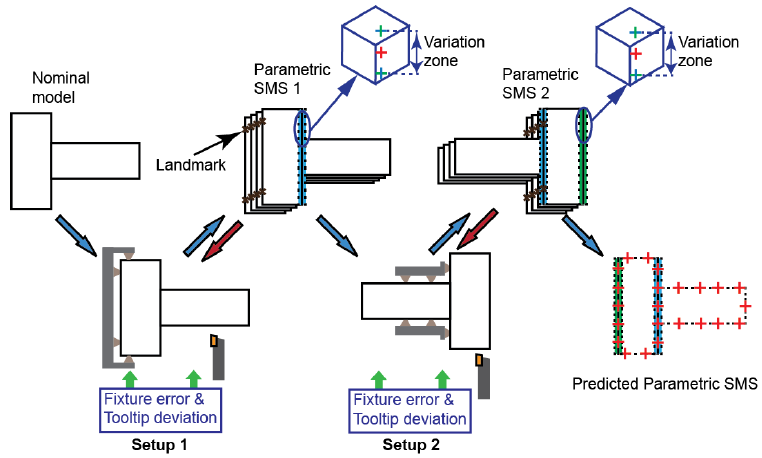
Figure 6. A typical multistage production of a shaft, with parametric SMSs as inputs in respective stations.